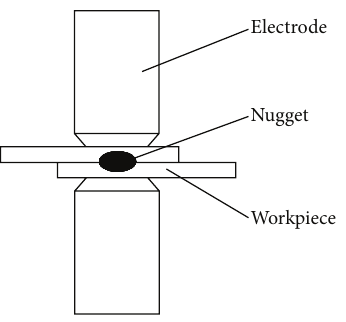
Figure 1: Resistance spot welding.